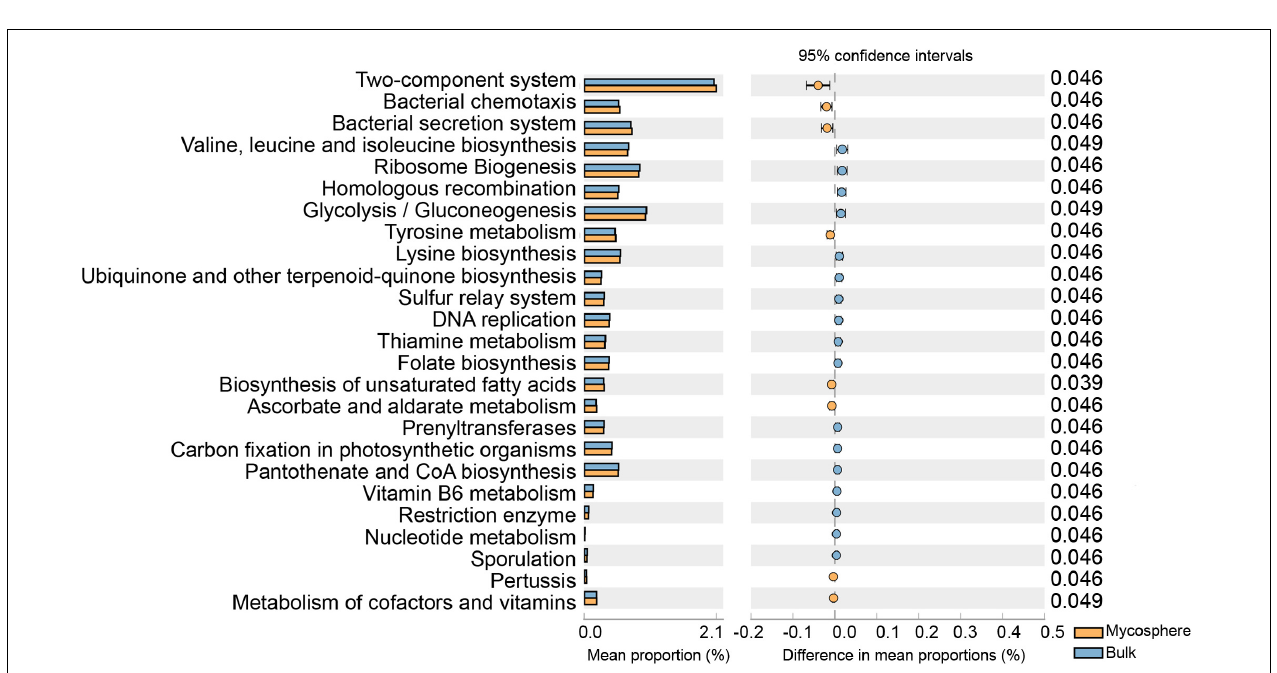
FIGURE 9 | Comparison of the Kyoto Encyclopedia of Genes and Genomes function between mycosphere and bulk soil.